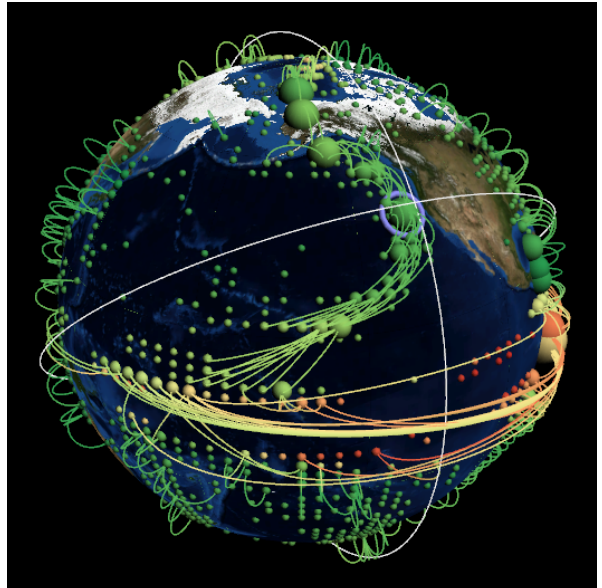
Figure 18. Spherical 3-D globe representation of a surface air tem- perature network (CGV). Node colour (green for small values, red for large values) and size encode the node attributes degree and shortest-path betweenness,